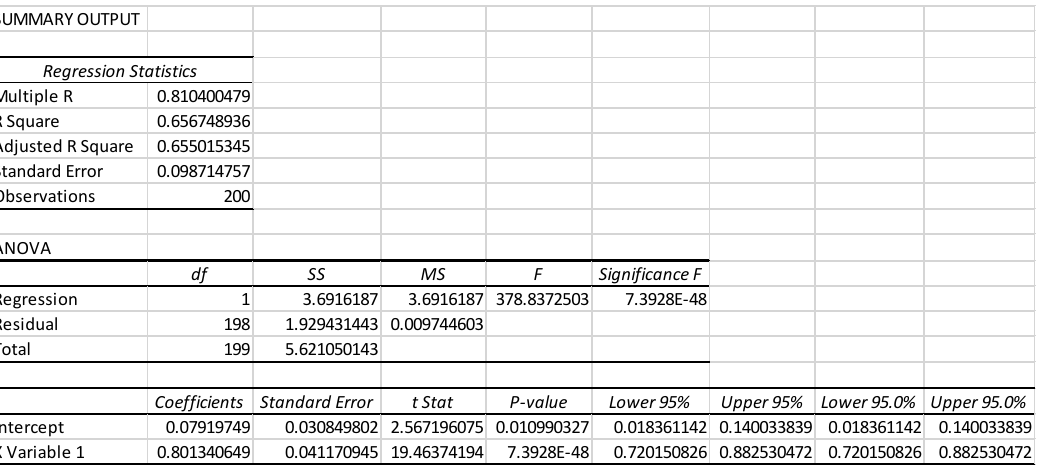
Regression Output for Independent Variable ME(%) and Dependent Variable FE(%) for Sample Size N=200 and Confidence Level of